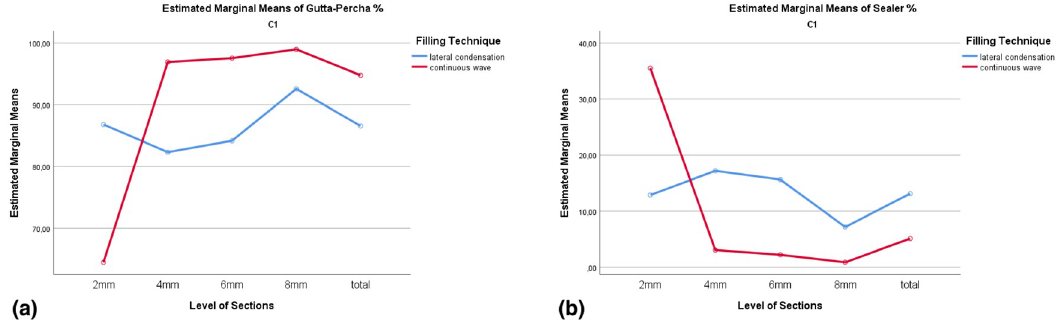
Fig 3. Interaction effects of filling techniques and level of sections on (A)gutta-percha (B)sealer percentages in C1-type.